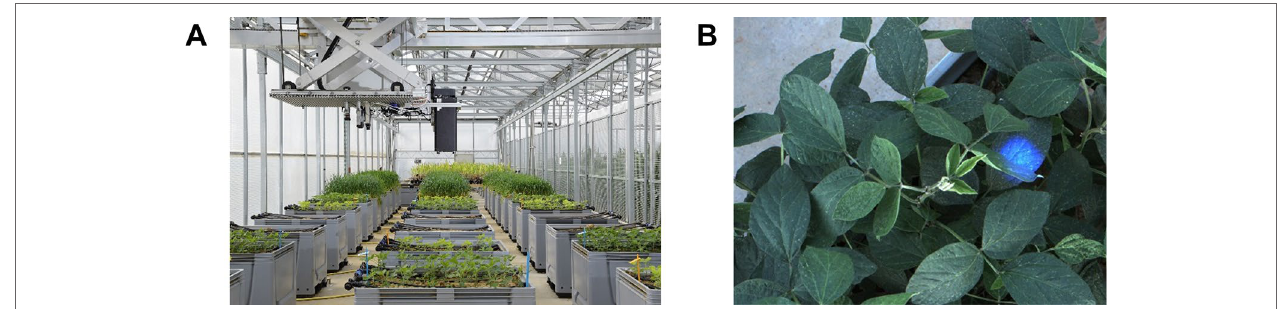
FIGURE 2 | The fully automated light-induced fluorescence transient (LIFT) system scanned crop canopy in 30 mm s −1 measuring every 2 s. (A) Plants were grown in containers under fluctuating conditions in an unheated glasshouse. The measuring distance was about 1 m. (B) The diameter of the measuring beam on the canopy was around 30